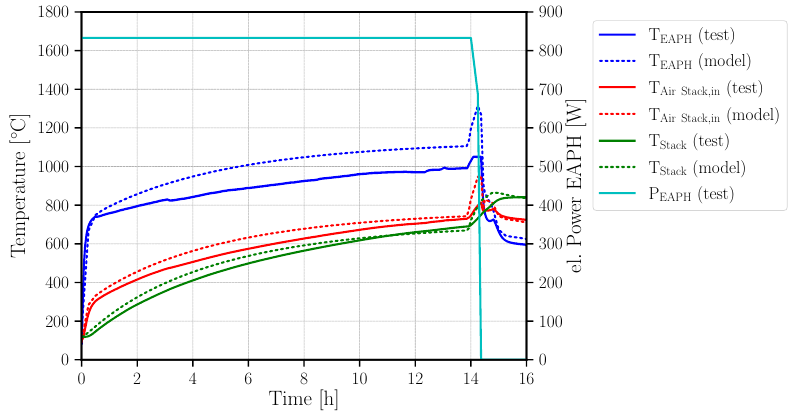
Figure 15. Modeled and measured temperatures of the EAPH, air inlet and the stack, plus the electrical power of the EAPH during heat-up of the system.